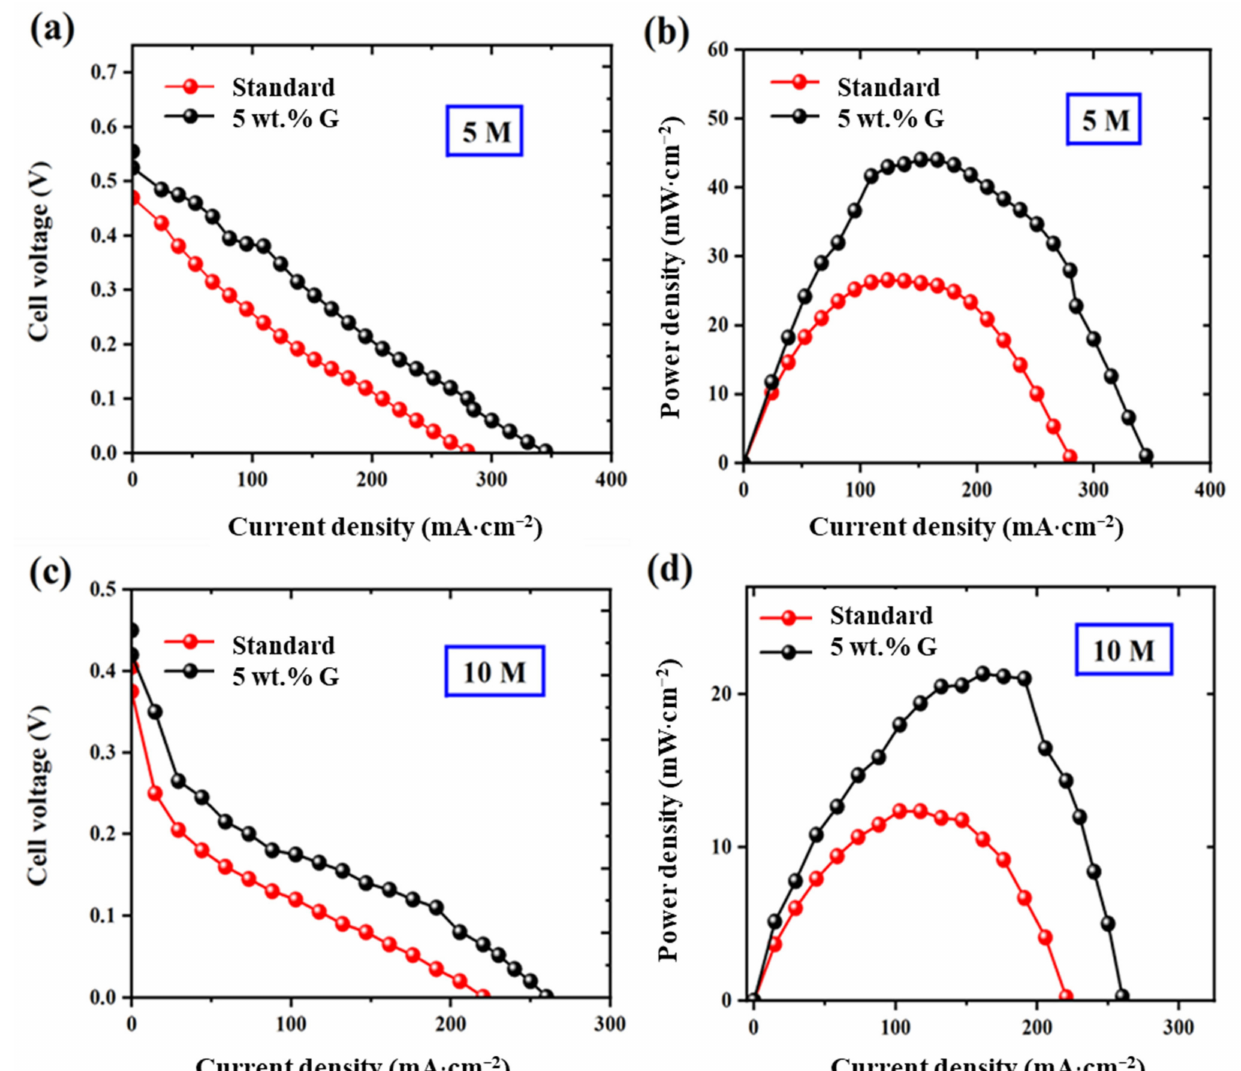
Figure 8. Polarization curve of standard and 5 wt.% graphene MEAs at ( a , b ) 5 M concentration and ( c , d ) 10 M